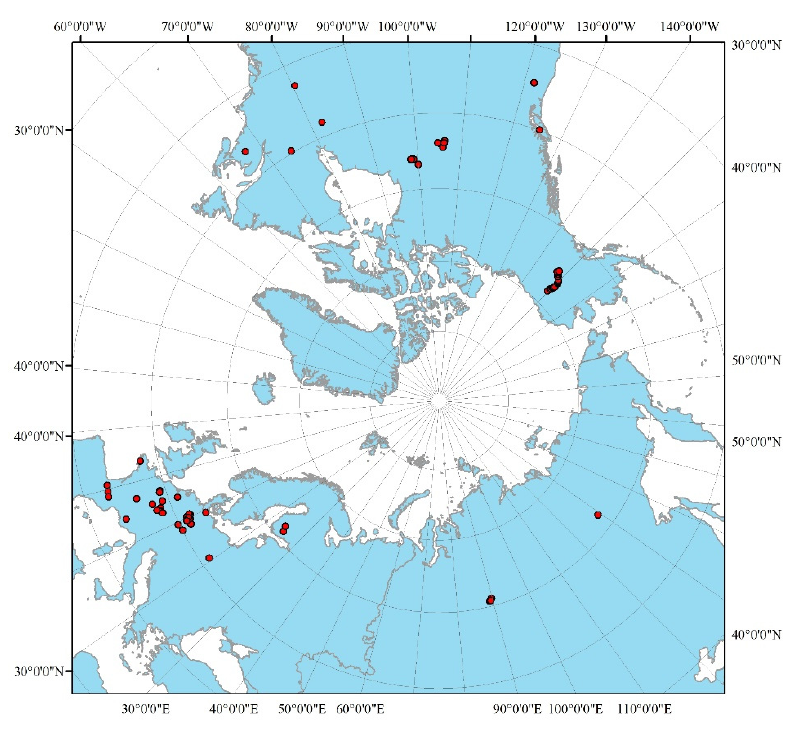
Figure 1. Distribution of validation sites collected from literature surveys.